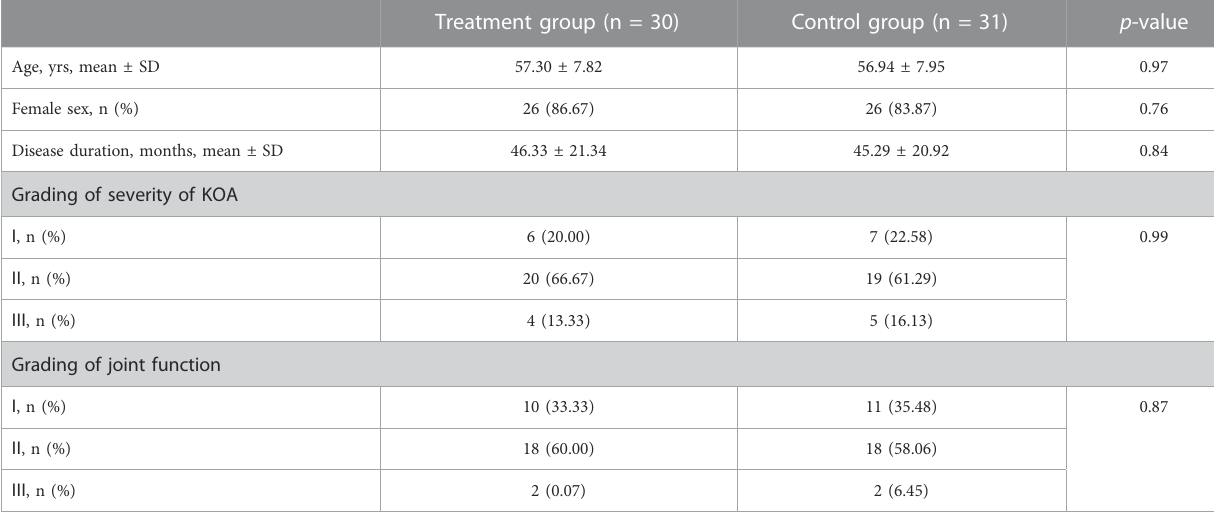
TABLE 1 Comparison of baseline characteristics between treatment group and control